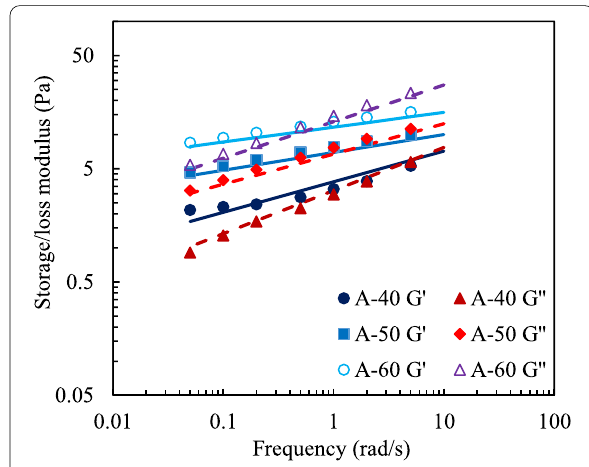
Fig. 15 Measured and predicted storage/loss modulus by modified palierne